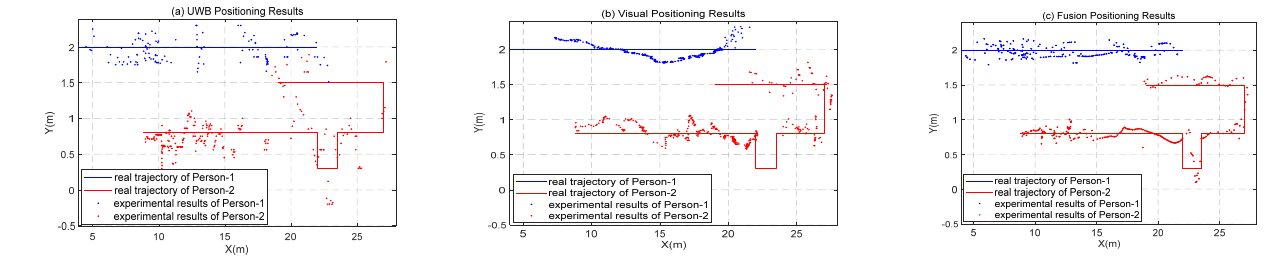
Figure 9. Positioning results.